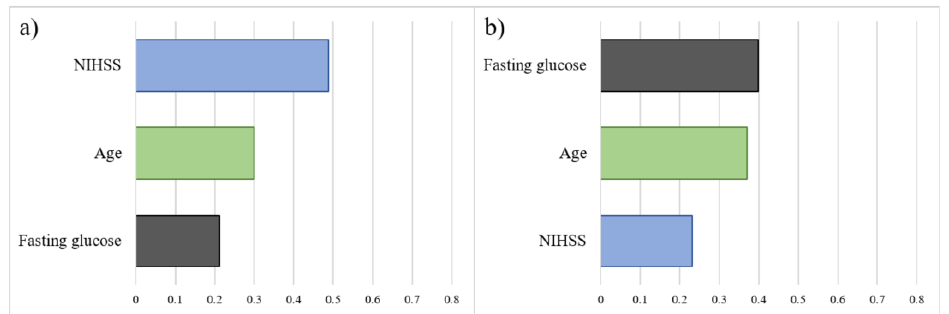
Figure 5. The importance and the ranking of the predictors of EVT with IVT and EVT without IVT subgroups. EVT, endovascular therapy; IVT, intravenous thrombolysis. ( a ) EVT with IVT. ( b ) EVT without